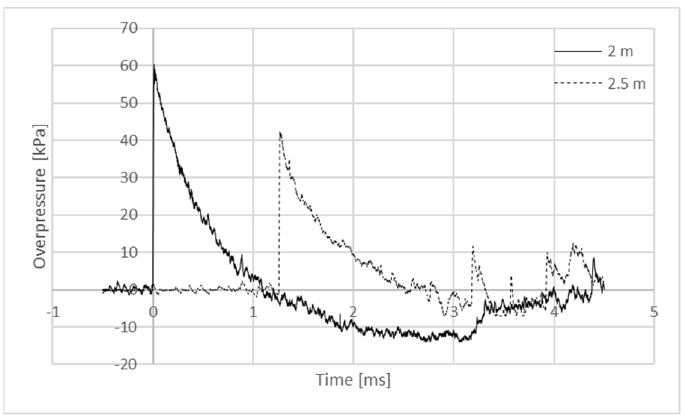
Figure 3. Air blast wave overpressure for ANPD composition.